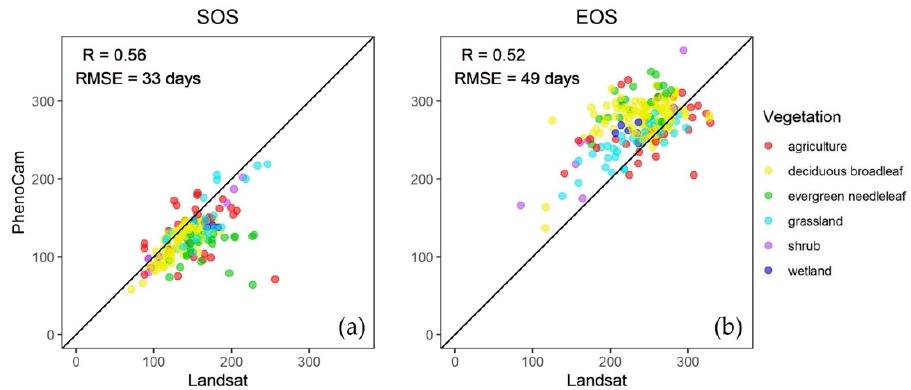
Figure 6. The correlation between Landsat and PhenoCam ( a ) SOS and ( b ) EOS DOY over 2016–2018.